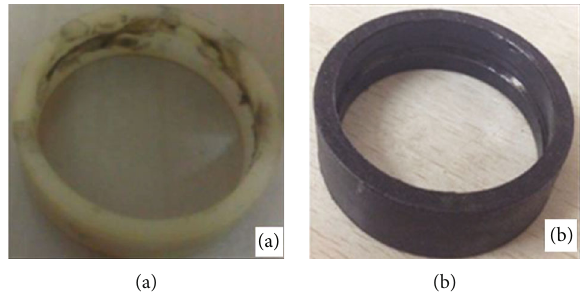
Figure 14: (a) Outer ring of nylon bearing. (b) Outer ring of GO- GFN bearing.